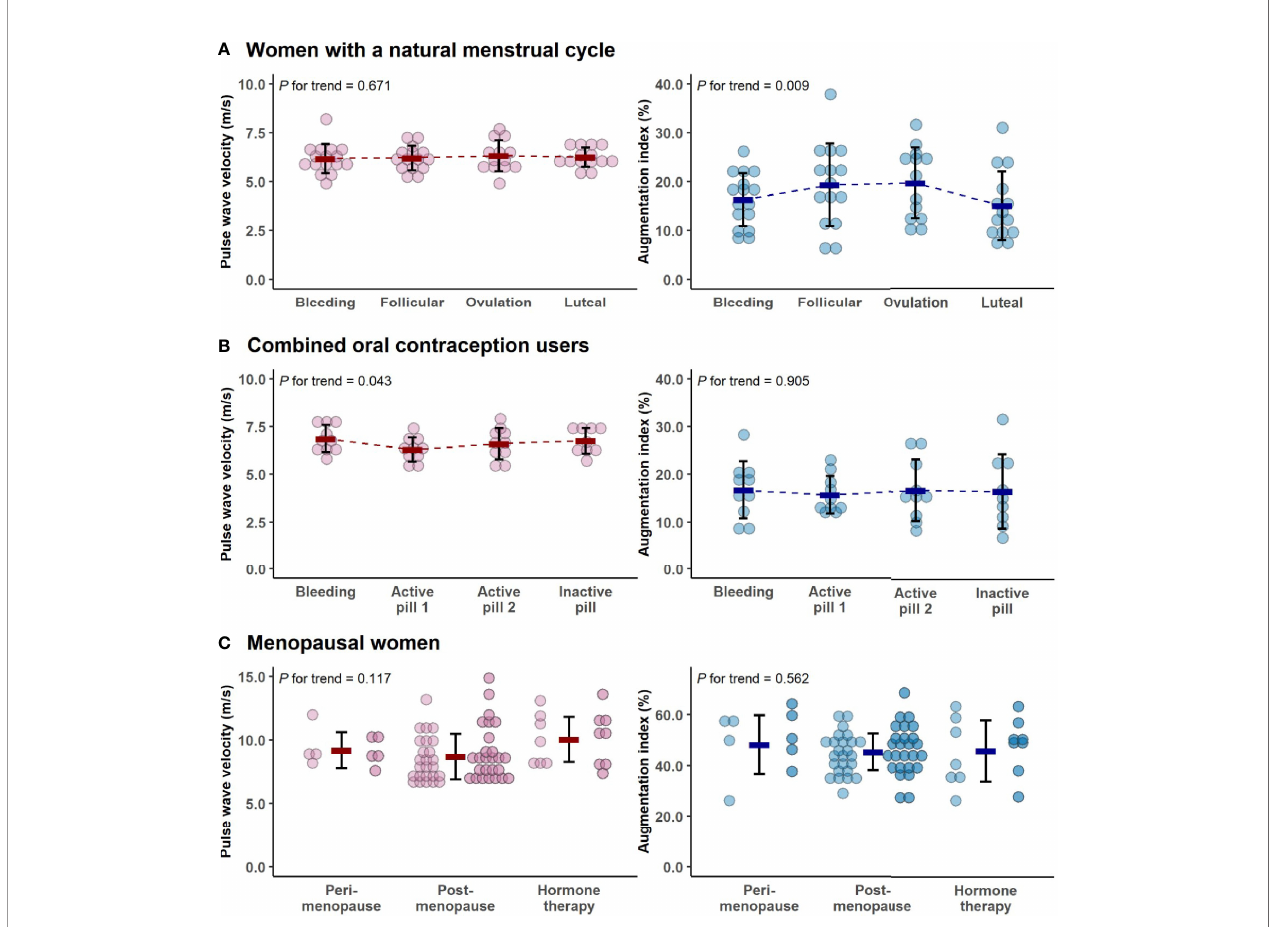
FIGURE 3 | The variations in pulse wave velocity and augmentation index within the menstrual cycle (A) , combined oral contraceptive-pill cycle phases (B) and menopausal groups (C) . In all fi gures, bold lines represent means with standard deviations. For menopausal women, the means were calculated as average concentrations of the two measurement points (the fi rst measurement point is presented with lighter and the second is with darker colors). Note the differing y-axes in younger and older women. P for trend is provided by Wald Chi-Squared Test of the generalized estimating equation models.